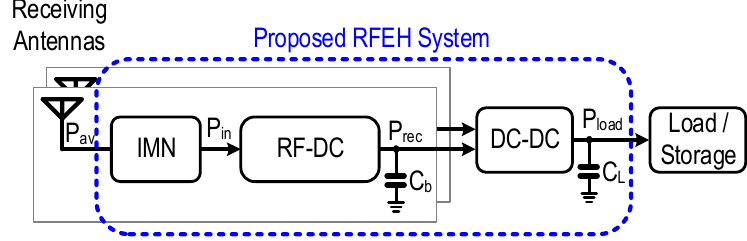
Figure 1. Single-frequency multi-channel RF energy harvesting